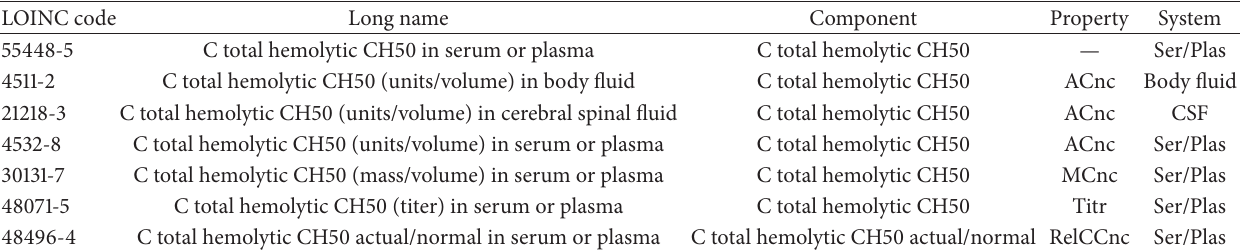
Table 1: Contribution of one single analysis, complement total hemolytic activity, CH50, to big data exemplified by LOINC coding. Seven different codes are attributed to the single CH50 analysis derived from difference in the long name, property, and the different body fluid systems in which CH50 can be measured.